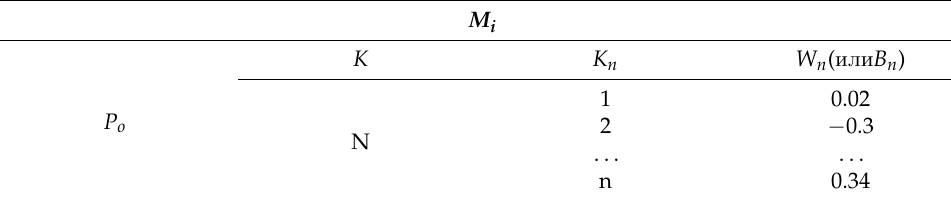
Table 9. Representation of the initial marking in the developed model.